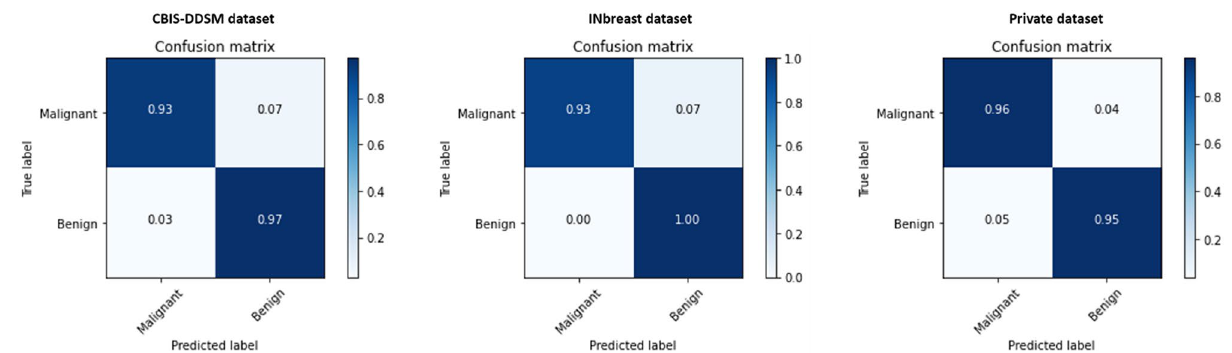
Figure 9. Confusion matrix of the stacked ensemble of models for the pathology classification on the mammography